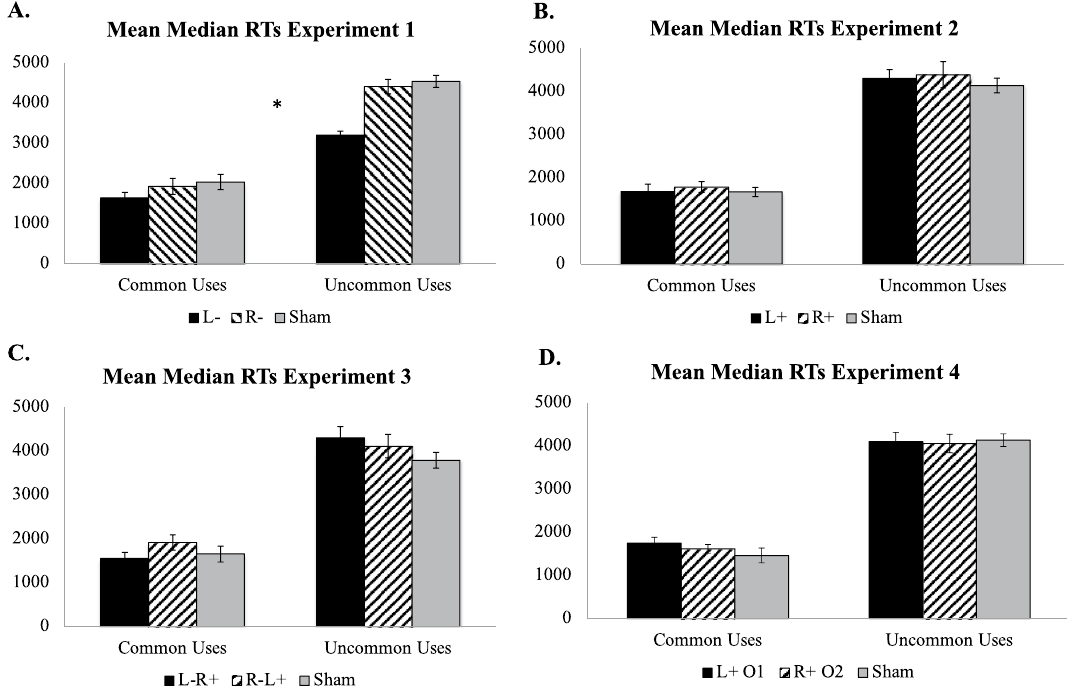
Figure 1. Voice onset mean median RT results for Experiments 1–4 by task and stimulation condition. ( A ) Voice onset mean median RTs for Experiment 1; ( B ) Voice onset mean median RTs for Experiment 2; ( C ) Voice onset mean median RTs for Experiment 3; ( D ) Voice onset mean median RTs for Experiment 4; L- = cathodal tDCS over left ventrolateral PFC; R- = cathodal tDCS over right ventrolateral PFC. L + = anodal tDCS over left ventrolateral PFC; R + = anodal tDCS over right ventrolateral PFC. L-R + = cathodal tDCS over left ventrolateral PFC with concurrent anodal tDCS over right ventrolateral PFC; R-L + = cathodal tDCS over right ventrolateral PFC with concurrent anodal tDCS over left ventrolateral PFC. L + O1 = anodal tDCS over left occipitotemporal cortex; R + O2 = anodal tDCS over right occipitotemporal cortex. RT = Reaction Times. The asterisk [*] represents p < .01 for the significant task × stimulation condition interaction for voice-onset RTs for Experiment